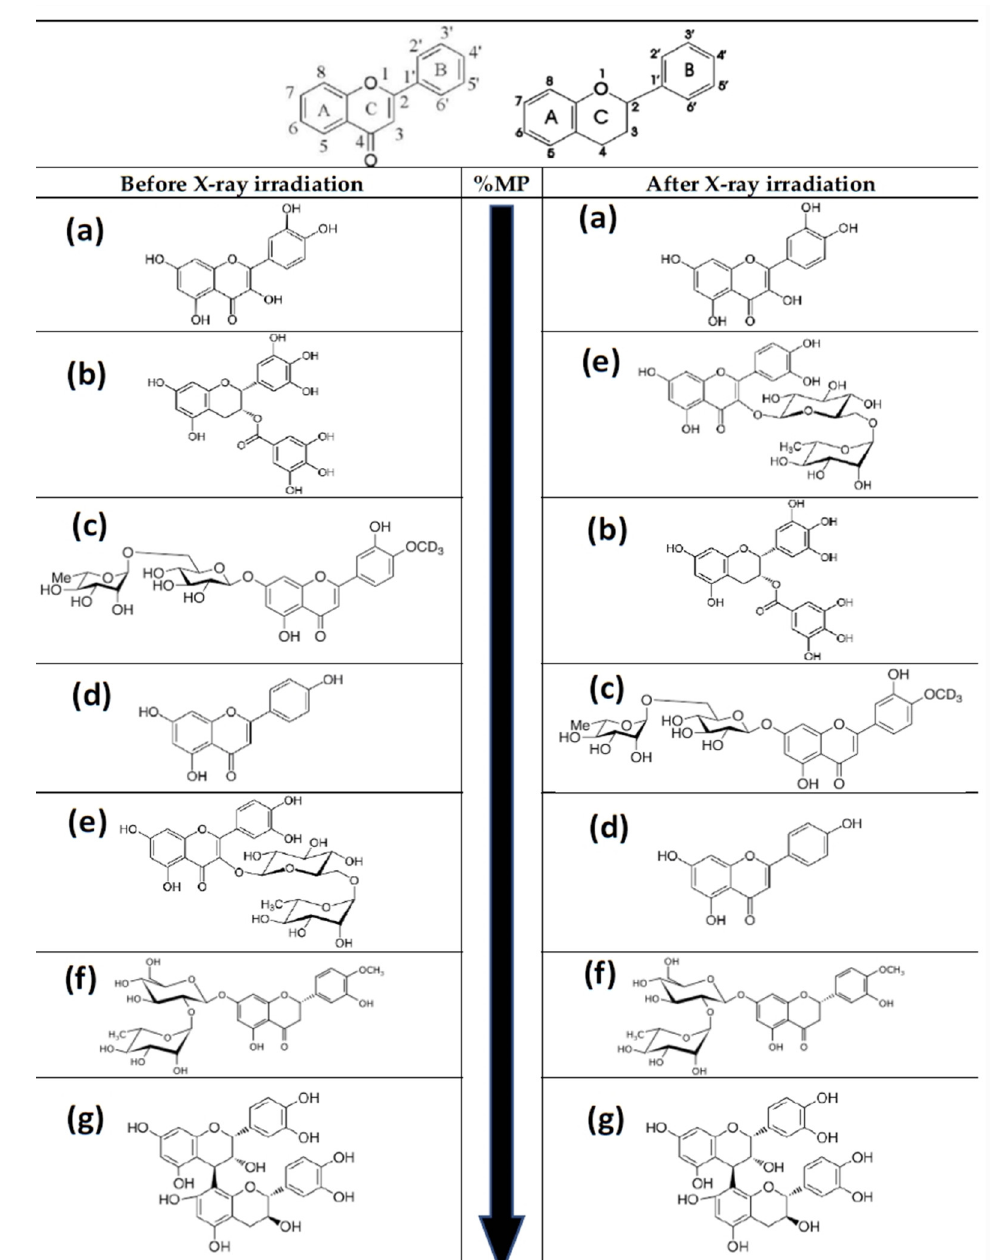
Figure 10. Basic structure of flavonoid skeleton with and without C-4 carbonyl group. Molecular structures of the flavonoids tested in this study from low to high (top to bottom) genoprotective capacity (see Table 2): ( a ) quercetin; ( b ) green tea extract (epigallocatechin-3-O-gallate, EGCG); ( c ) diosmin; ( d ) apigenin; ( e ) rutin; ( f ) citrus extract (neohesperidin); ( g ) procyanidins. Before irradia- tion: Quercetin < EGCG (green tea) < Diosmin < Apigenin < Rutin < Neohesperidin (citrus extract) < Procyanidins. After irradiation: Quercetin < Rutin < EGCG (green tea) < Diosmin < Apigenin < Neohesperidin <